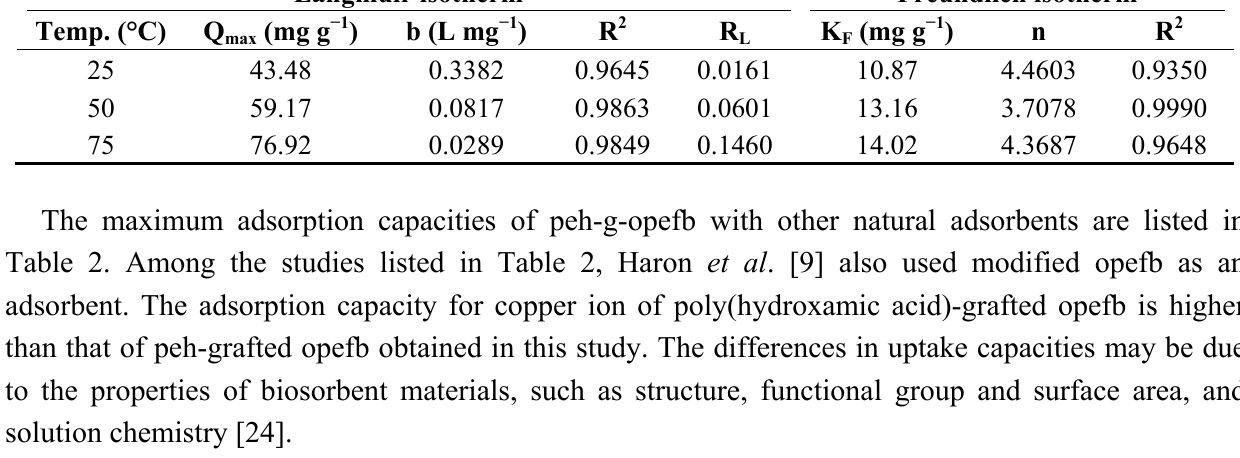
) for copper of other low-cost biosorbents. max